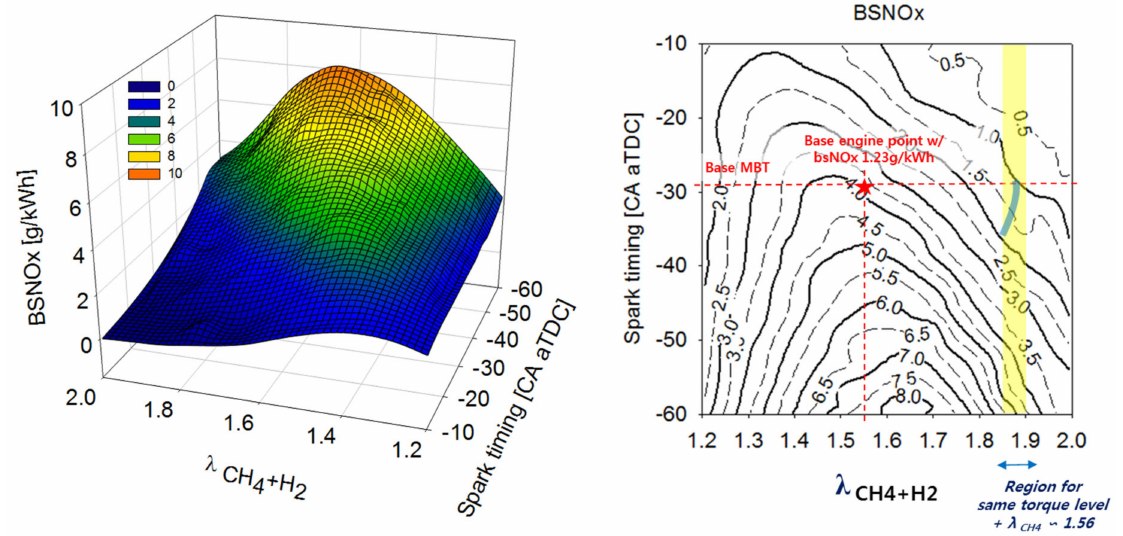
Figure 10. Response surface model: brake specific NOx as functions of spark timing and hydrogen added methane based EAR @1300